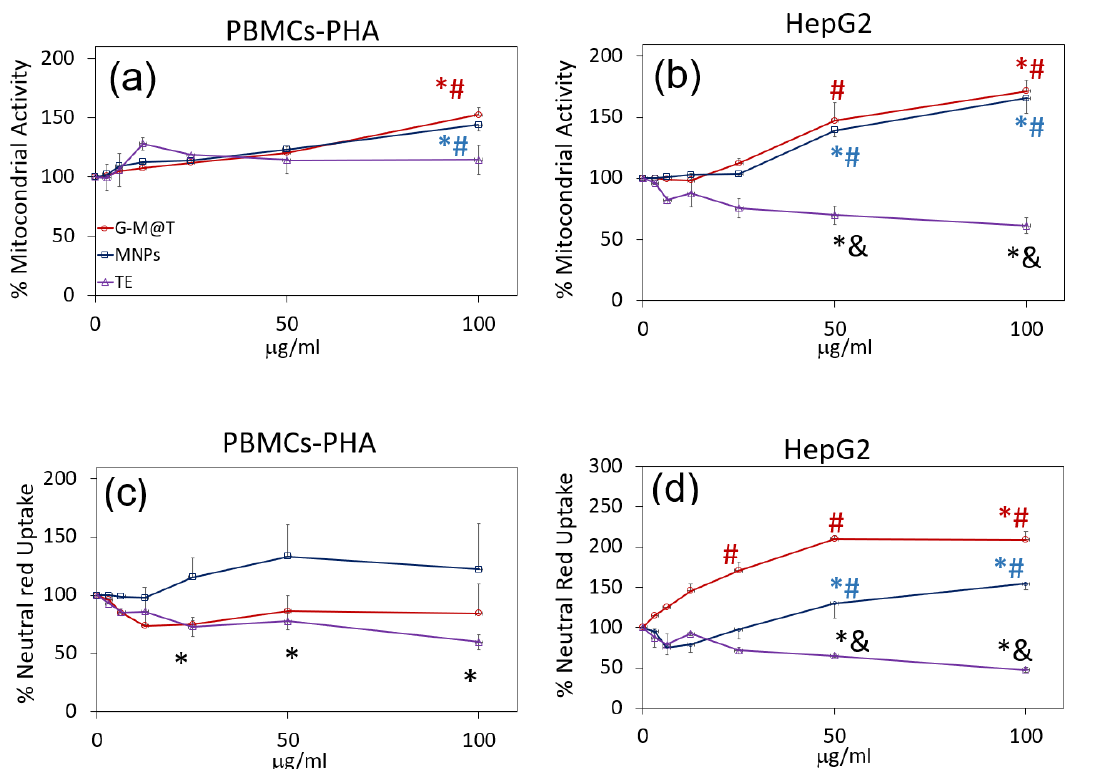
Figure 9. Toxicity of MNPs, G-M@T, and TE in PBMCs ( a , c ) and HepG2 cells ( b , d ) by MTT assay ( a , b ) or Neutra Red Uptake assay ( c , d ) after 48 h of exposure. * p < 0.05 vs. control, & p < 0.05 vs. MNPs, # p < 0.05 vs. TE. ANOVA test, n = 3 in triplicate.